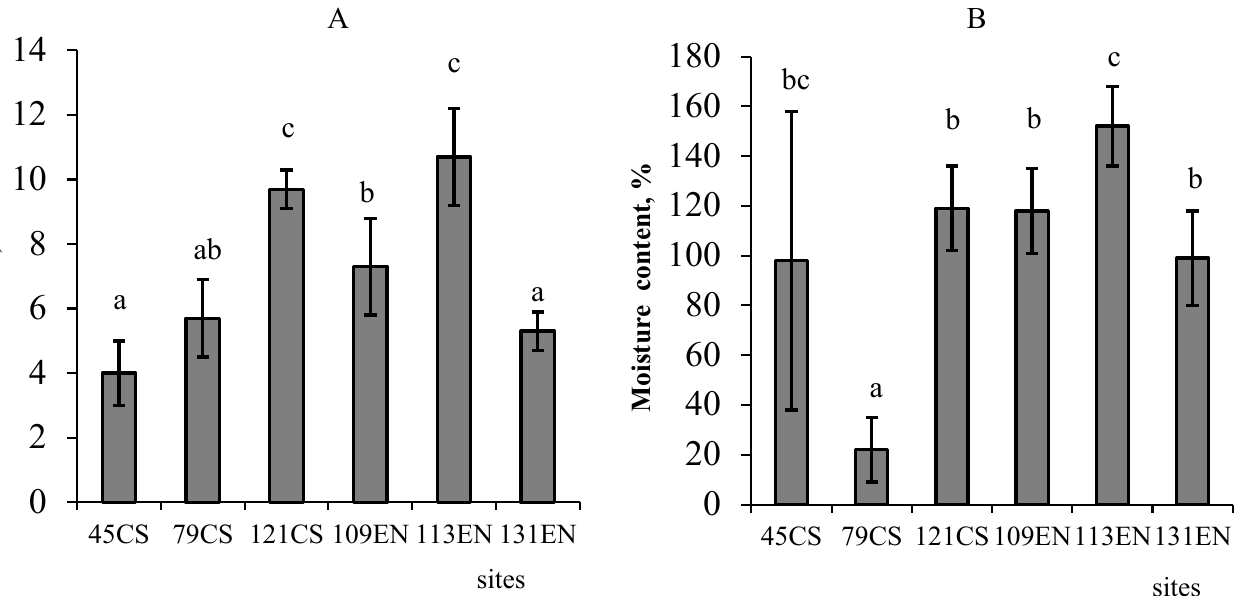
Figure 2. The thickness of the organic horizon ( A ) and moisture content ( B ) in the study soils ( n = 3, the error bars are the standard errors). Abbreviation: CS—Central Siberia, EN—European North. The number before the abbreviation means how many years have passed since the last fire. Different lowercase letters indicate significant differences at p < 0.05.